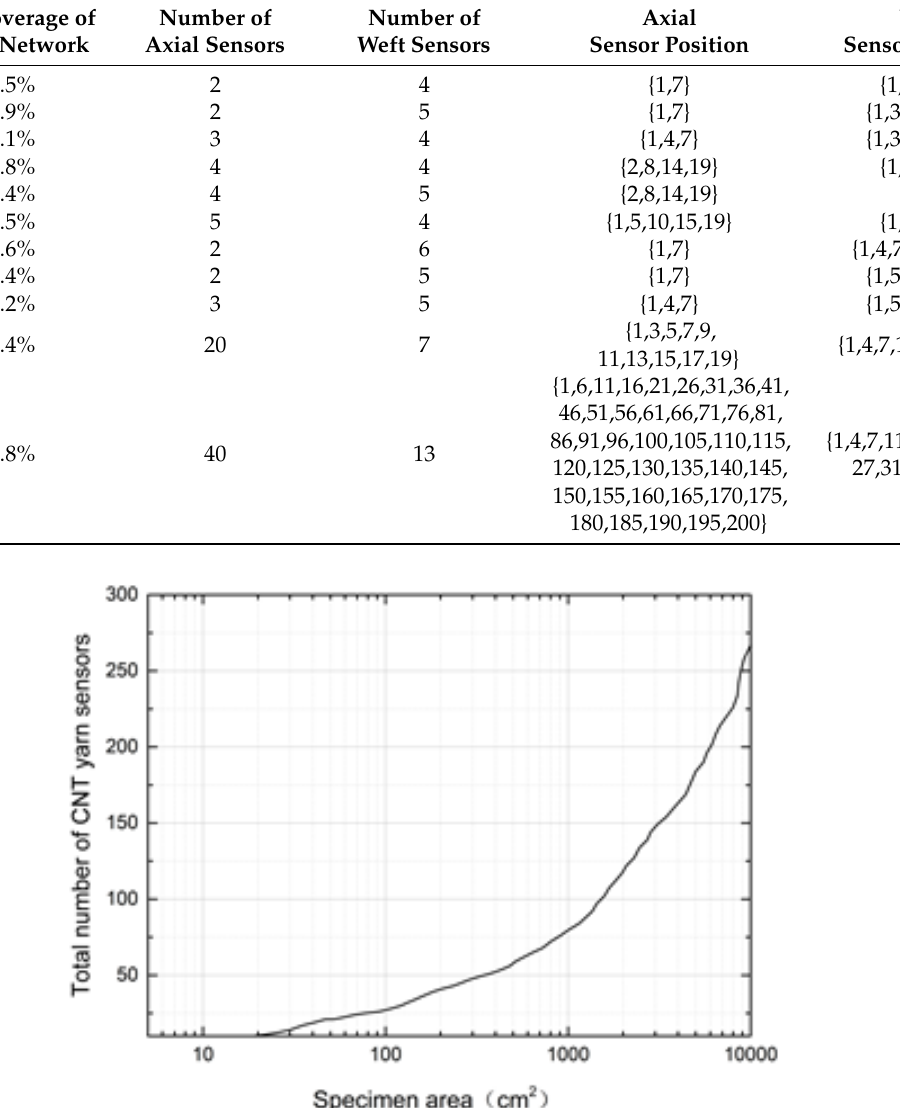
Table 4. Optimal configuration of CNT yarn sensors embedded in different size specimens.